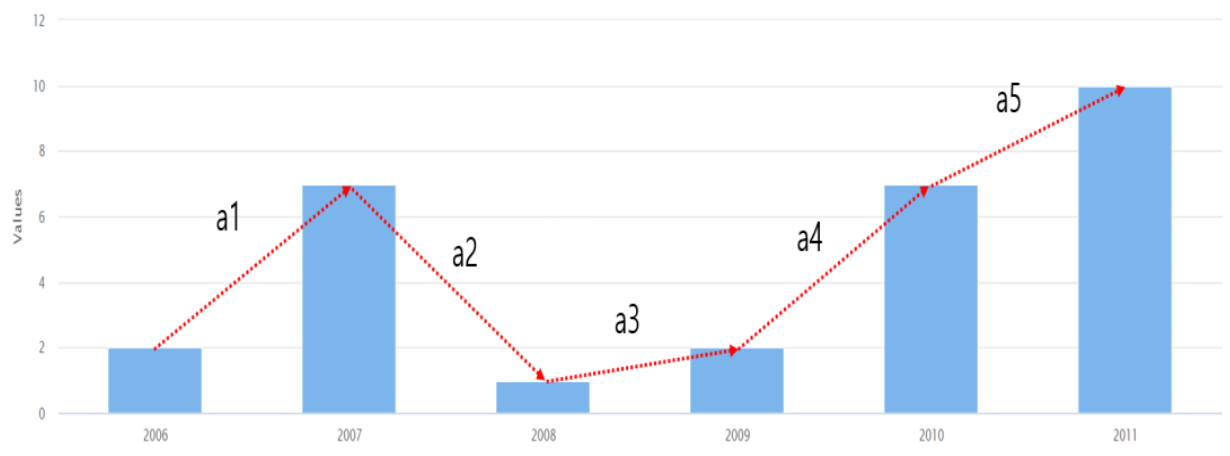
Figure 2. The concept of fast growth analysis using the acceleration of emergence.